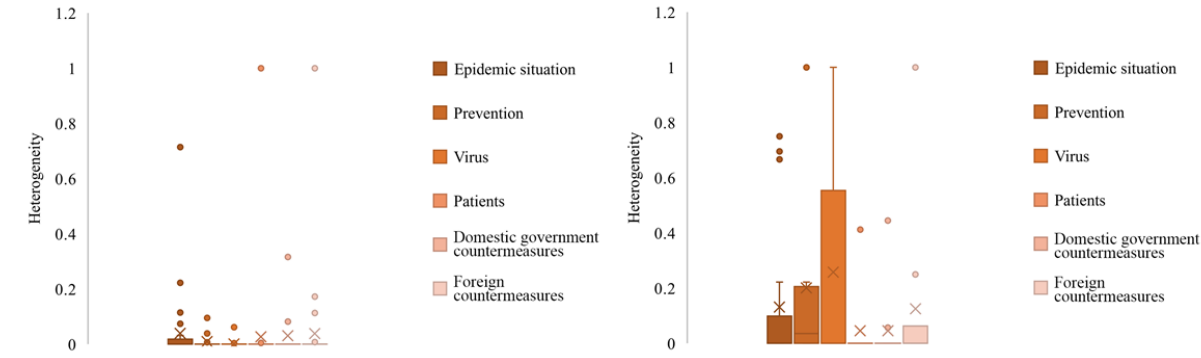
Figure 6. Heterogeneity based on the distribution of users' attitudes within each community node in retweeting (left) and commenting (right) community networks toward rumor rebuttal under the top six topics. The × symbols and circles represent means and outliers of the heterogeneity values, respectively.